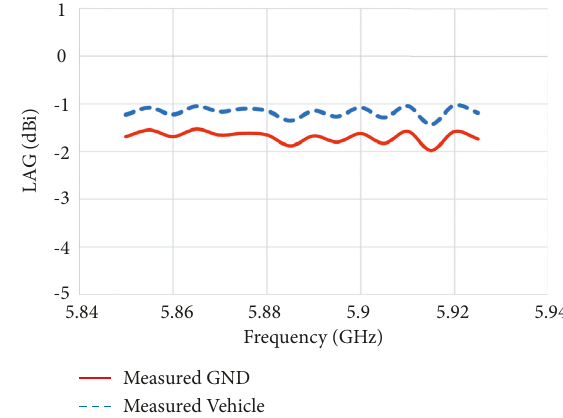
Figure 15: V2X measured LAG on a ground plane and a vehicle